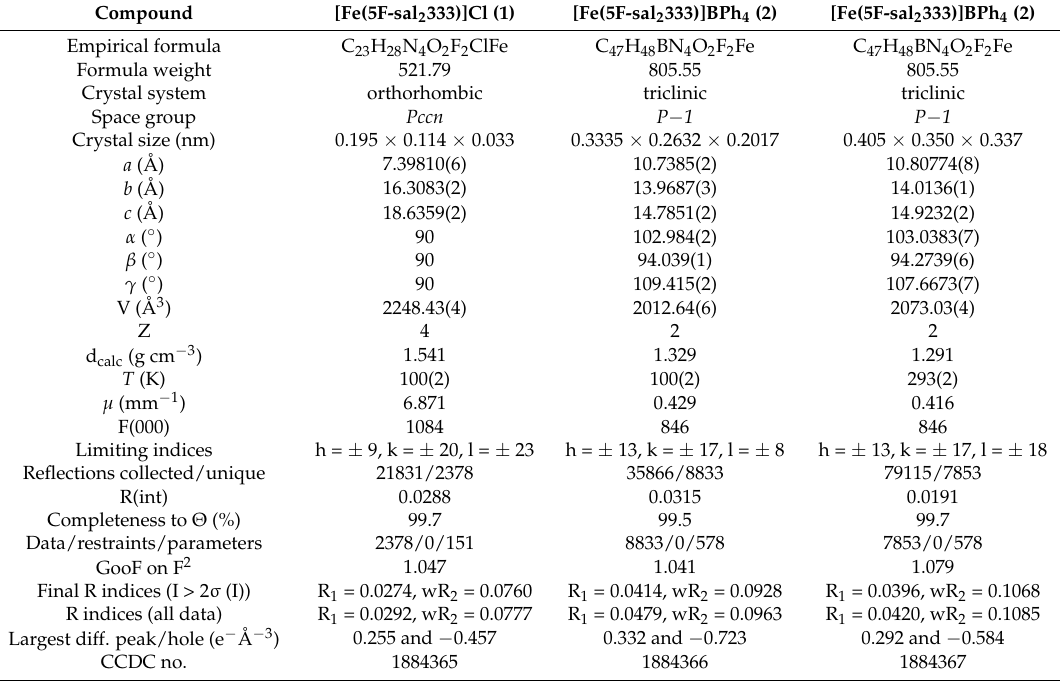
Table A1. Crystallographic details for complexes 1 and 2